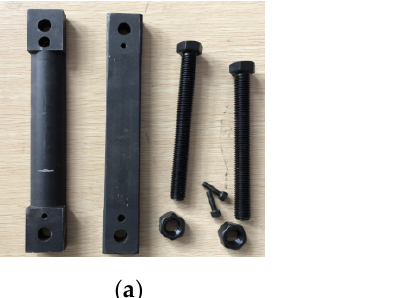
Figure 4. Prestressed CFRP cloth relaxation tensioning: ( a ) relaxation loss testing device of CFRP cloth; and ( b ) side view of the testing device.